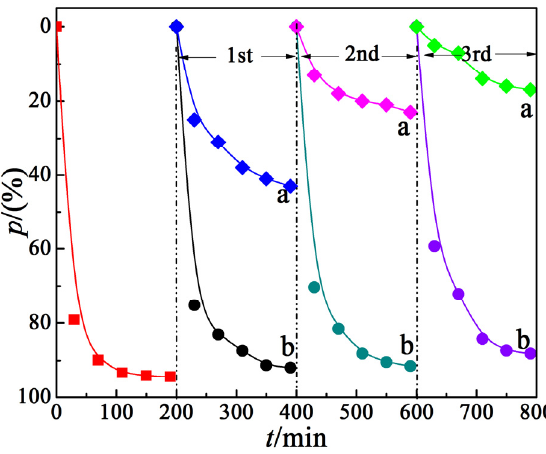
Figure 9. Recycle use of α -Fe 2 O 3 @PHCMs on adsorption of MV: ( a ) without regeneration; and ( b ) with H 2 O 2 regeneration.